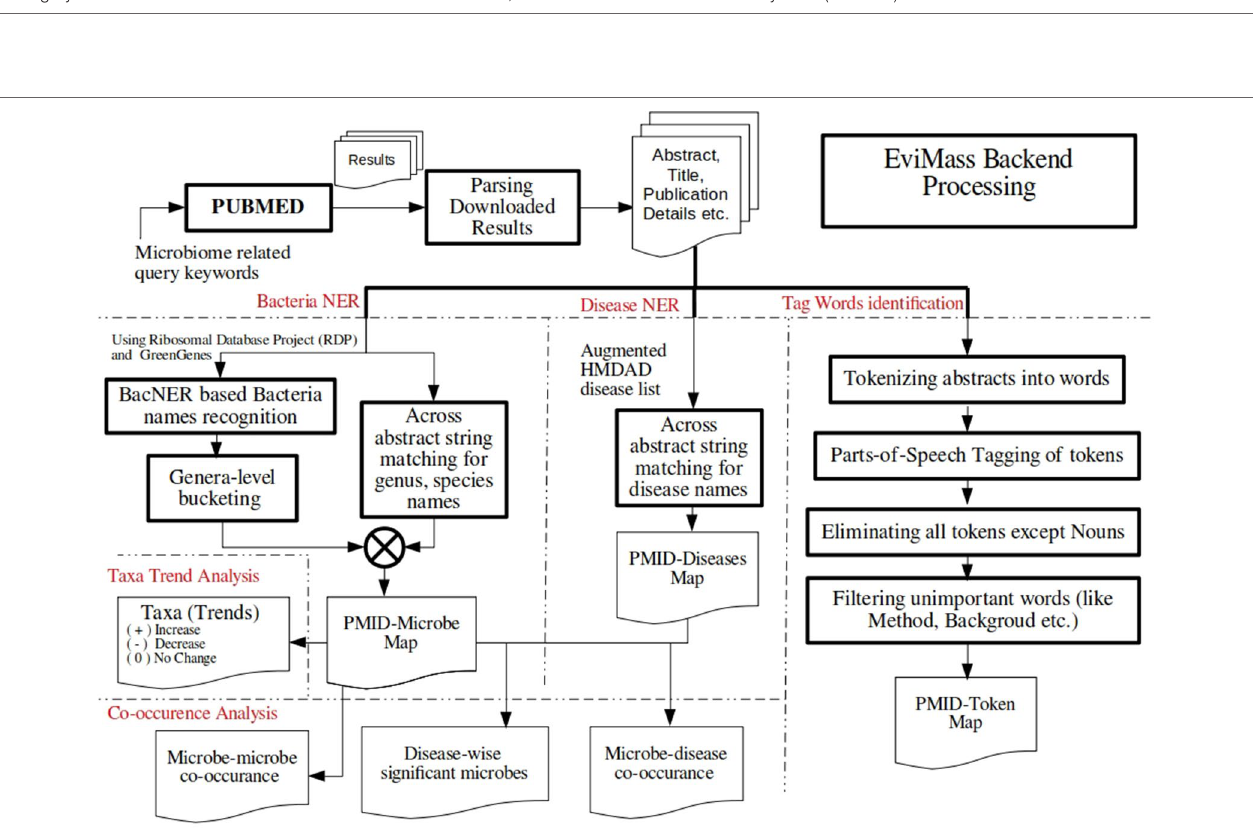
FIGURE 5 | Flowchart describing the various steps involved in development of the EviMass